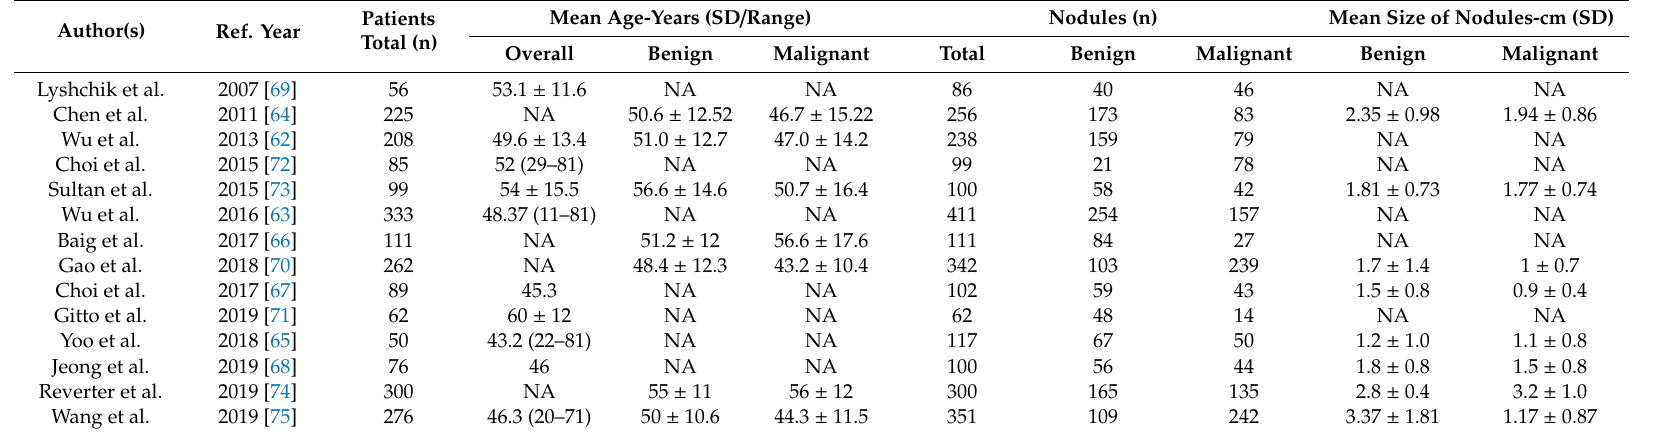
Table 1. Main patient characteristics of the included